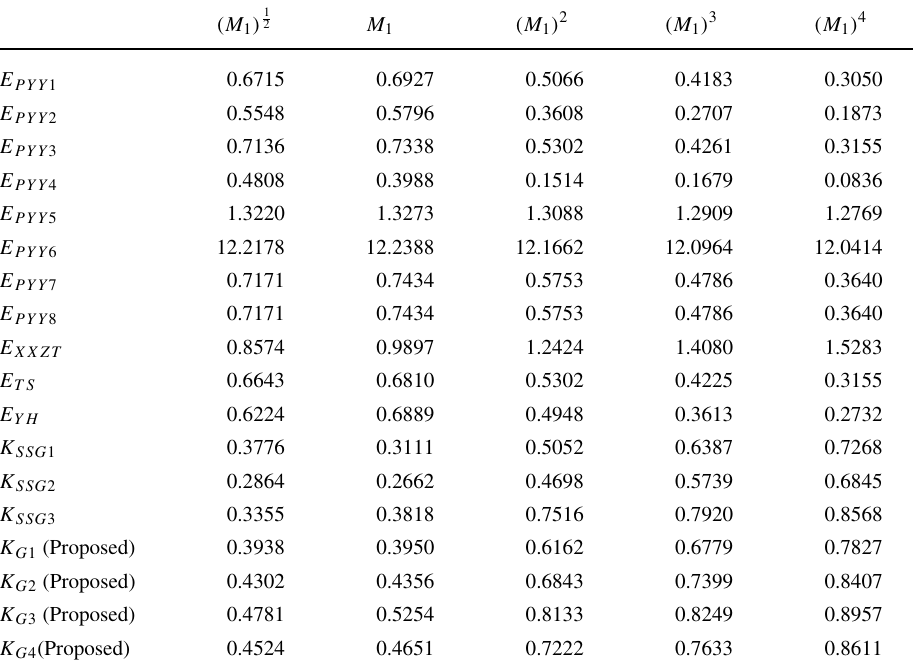
Table 7 Values of the PF measures of entropy/knowledge regarding Example